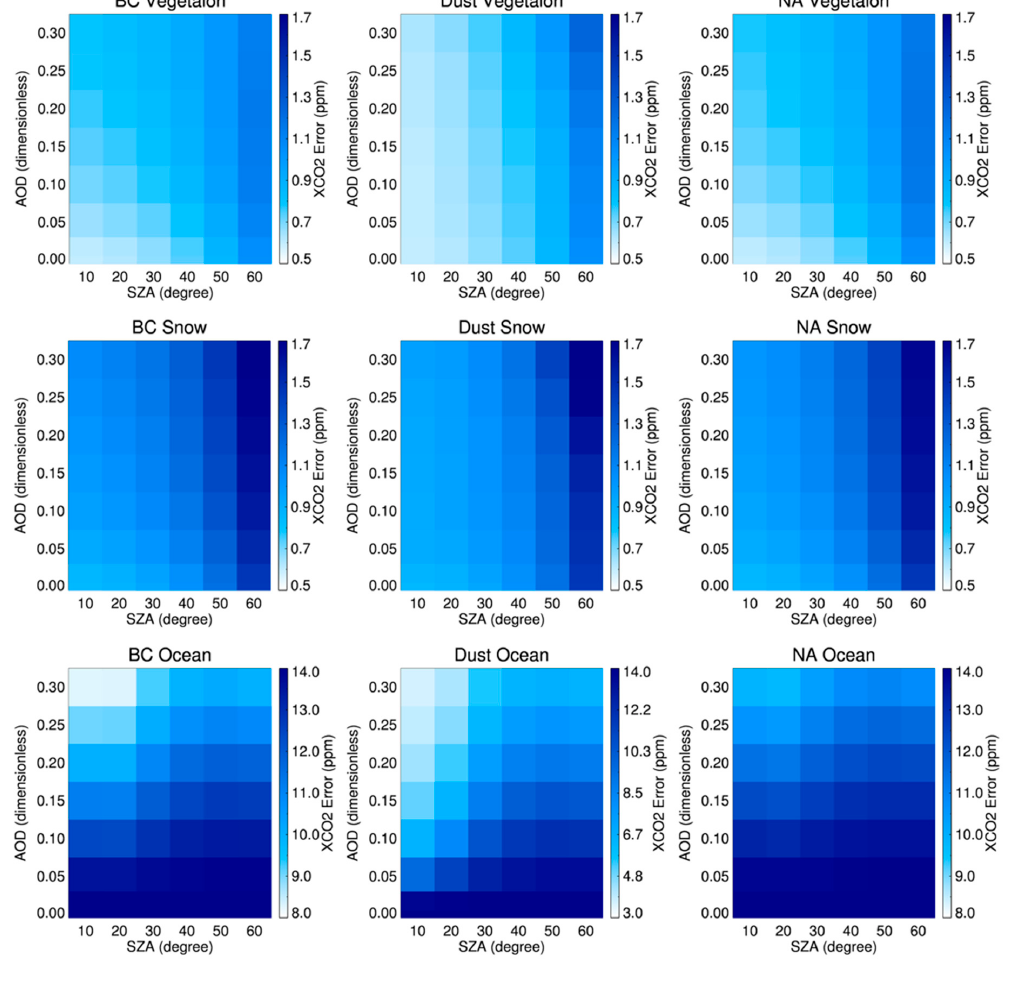
Figure 3. A posteriori XCO 2 retrieval errors for Black Carbon (BC) ( left column), dust ( middle column) and Non-Absorbing (NA) ( right column) aerosol types as a function of AODs and Solar Zenith Angels (SZAs) for vegetation ( top panel), snow ( middle panel) and ocean ( bottom panel). The column averaging kernels were analysed at the same time as the analysis of a posteriori XCO 2 retrieval errors. Figure 4 shows the column averaging kernels at different SZAs for a fixed AOD value of 0.3 and for the assumed aerosol and surface types. The column averaging kernels for BC and NA aerosol types with an AOD of 0.3 show similar shape patterns, as compared to patterns under aerosol-free conditions. Figure 4 also shows that the column averaging kernels are close to unity near the surface over vegetation and snow surfaces, but decrease with decreasing pressure above ~400 hPa. This means that the retrieval loses its sensitivity at high altitudes in the upper troposphere. It is also suggested that the column averaging kernels with respect to altitude are decreased more at higher SZAs. However, for the dust aerosol type with an AOD of 0.3, the retrievals largely lose their sensitivity near the surface, as well as compared to the sensitivity for BC and NA aerosol types. In addition, a maximum of the column averaging kernels is shown at ~800 hPa, which